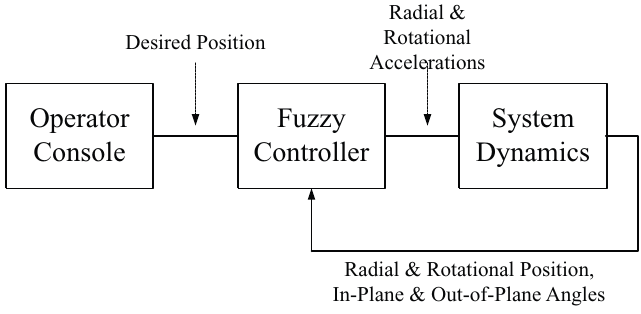
Fig. 3. System block diagram with fuzzy logic controller.